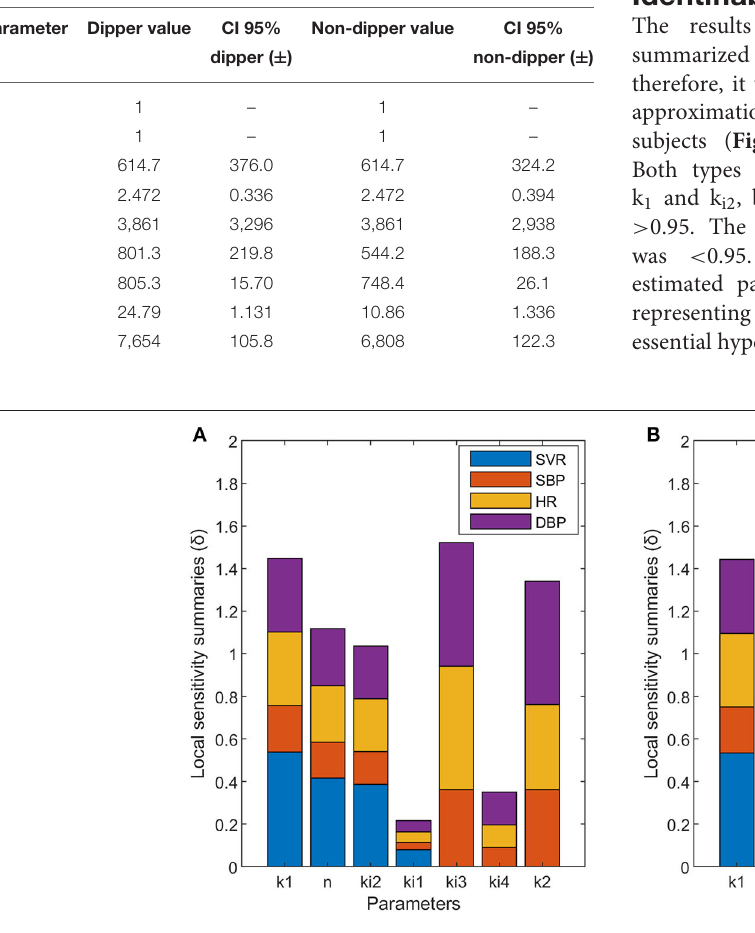
FIGURE 4 | Local sensitivity summaries ( δ ) calculated for each parameter with respect to each variable designated with different colors: SVR (blue), SBP (orange), HR (yellow), and DBP (purple) of dipper (A) and non-dipper (B) subjects.